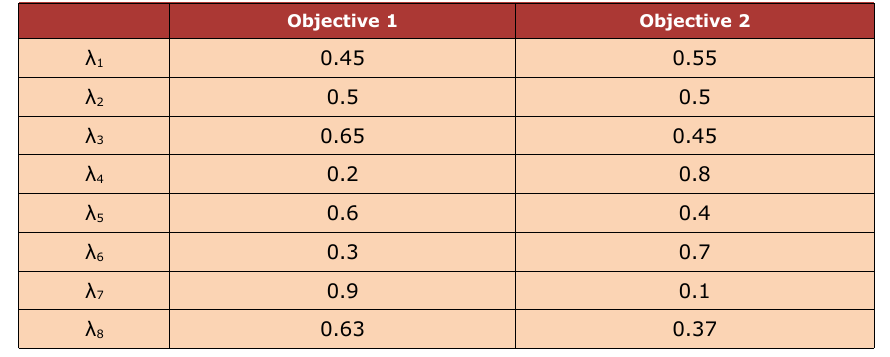
Table 7. Weight vectors for each objective